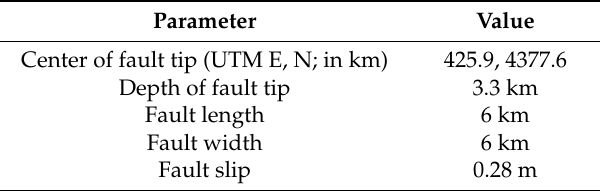
Table 6. Parameters of seismic fault determined from inversion of InSAR data.